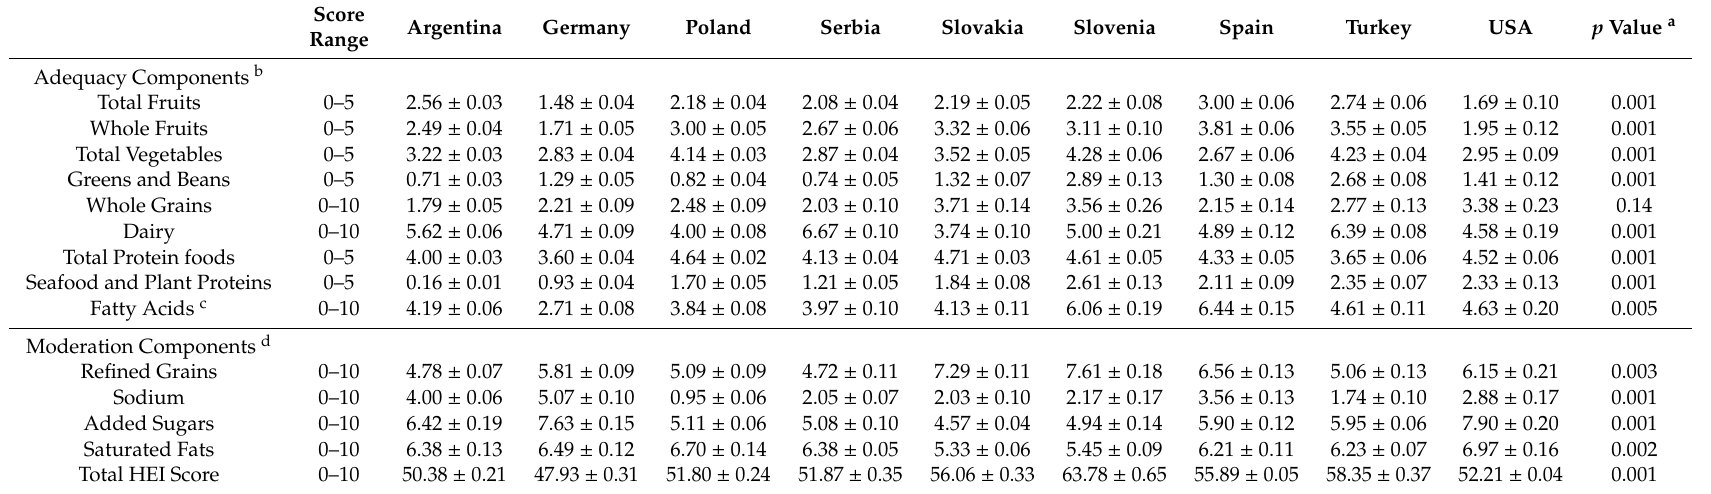
Table 4. Healthy Eating Index-2015 Component and Total Diet Quality Scores by